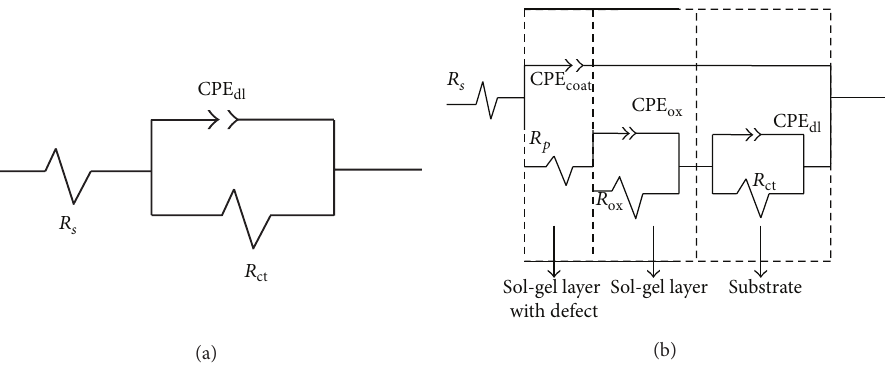
Figure 6: Equivalent circuits of samples after 1 hour immersion in 3.5 wt.% NaCl electrolyte: (a) bare and coated one dried at 700 ∘ C and (b) coated and dried at 200 ∘ C and 400 ∘ C.